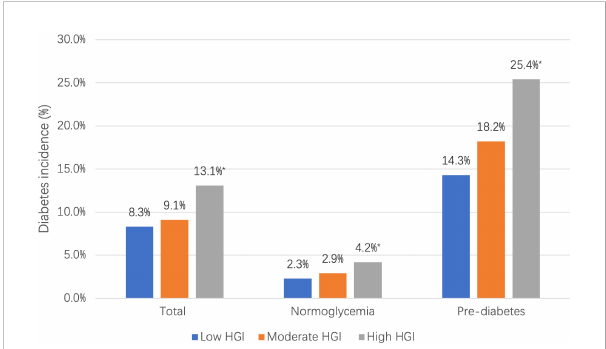
FIGURE 3 Incidence of diabetes for HGI categories by baseline glucometabolic status # Glucometabolic status is assessed using oral glucose tolerance test results (including fasting plasma glucose and 2-h plasma glucose). *compared with low HGI group, P < 0.05 HGI: hemoglobin glycation